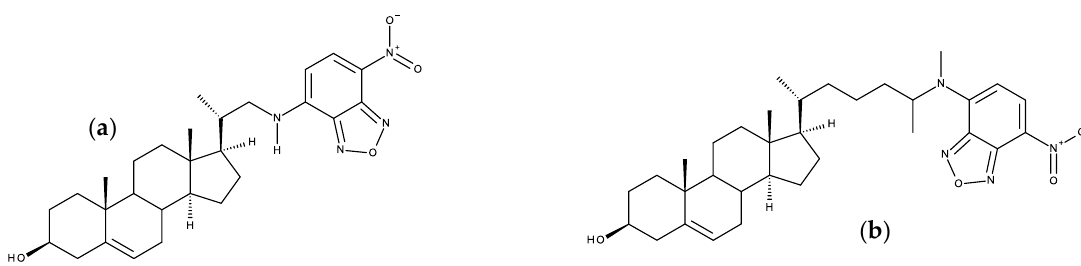
Figure 16. Structures of NBD side-chain labeled sterols. ( a ) 22-NBD- Chol; ( b )